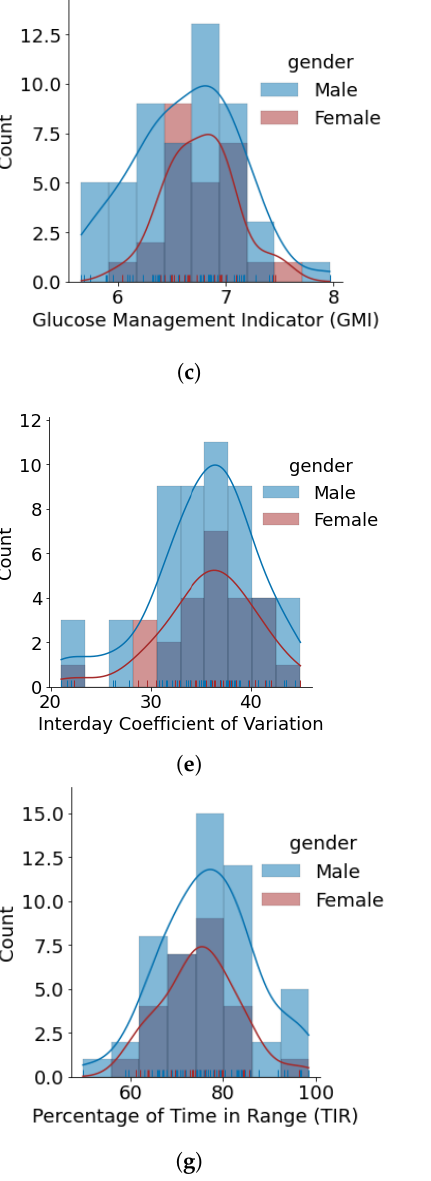
Figure 5. Glucose variability outcomes for individuals using open-source AID systems, based on gender. Total number of males and females is 50 and 28, respectively. ( a ) HBGI. ( b ) LBGI. ( c ) GMI. ( d ) J_index. ( e ) Glucose Coefficient of Variation. ( f ) Glucose Standard Deviation. ( g ) Glucose Percentage of Time Inside Range (TIR). ( h ) Glucose Percentage of Time Outside Range